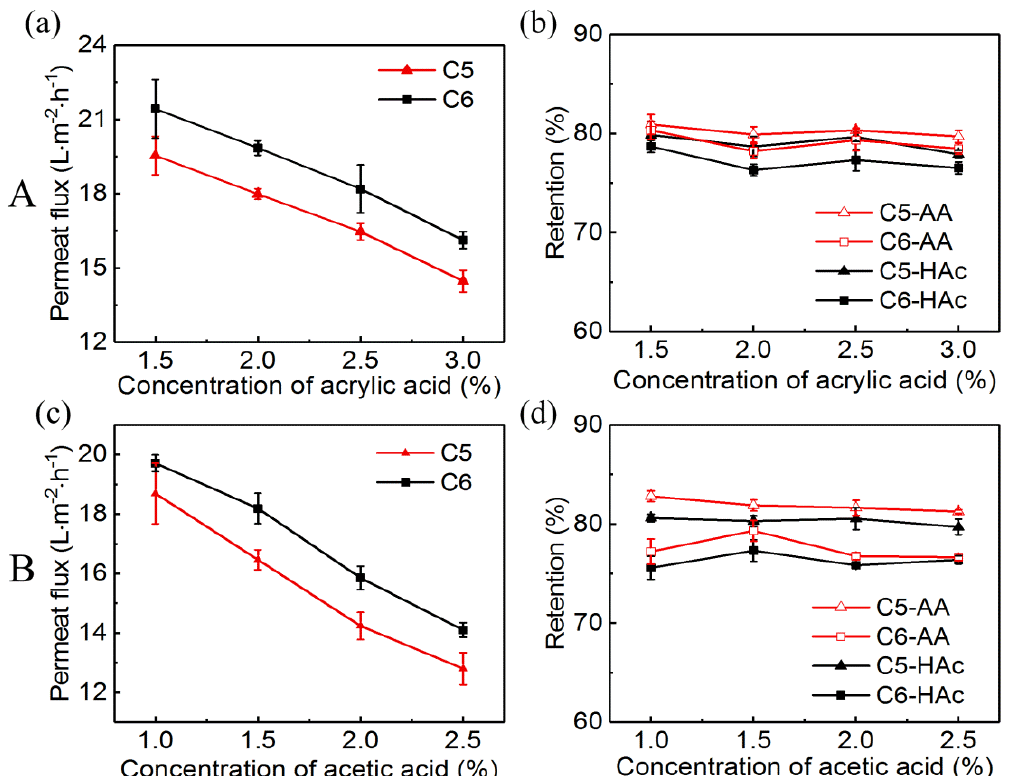
Figure 4. Effect of the feed concentration of acrylic acid (group A ) on ( a ) permeate flux and ( b ) acrylic acid and acetic acid retentions, and the feed concentration of acetic acid (group B ) on ( c ) permeate flux and ( d ) acrylic acid and acetic acid retentions. Pressure: 3.5 MPa; temperature: 25 °C.